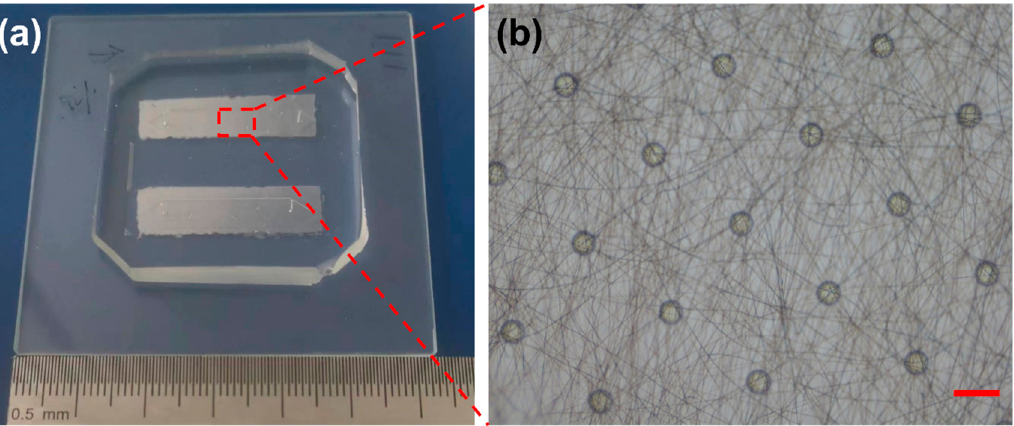
Figure 2. Cancer cell capture microchip ( a ) and PLGA nanofibers coupled with micropillars in the microchannel ( b ). The scale bar is 100 µ